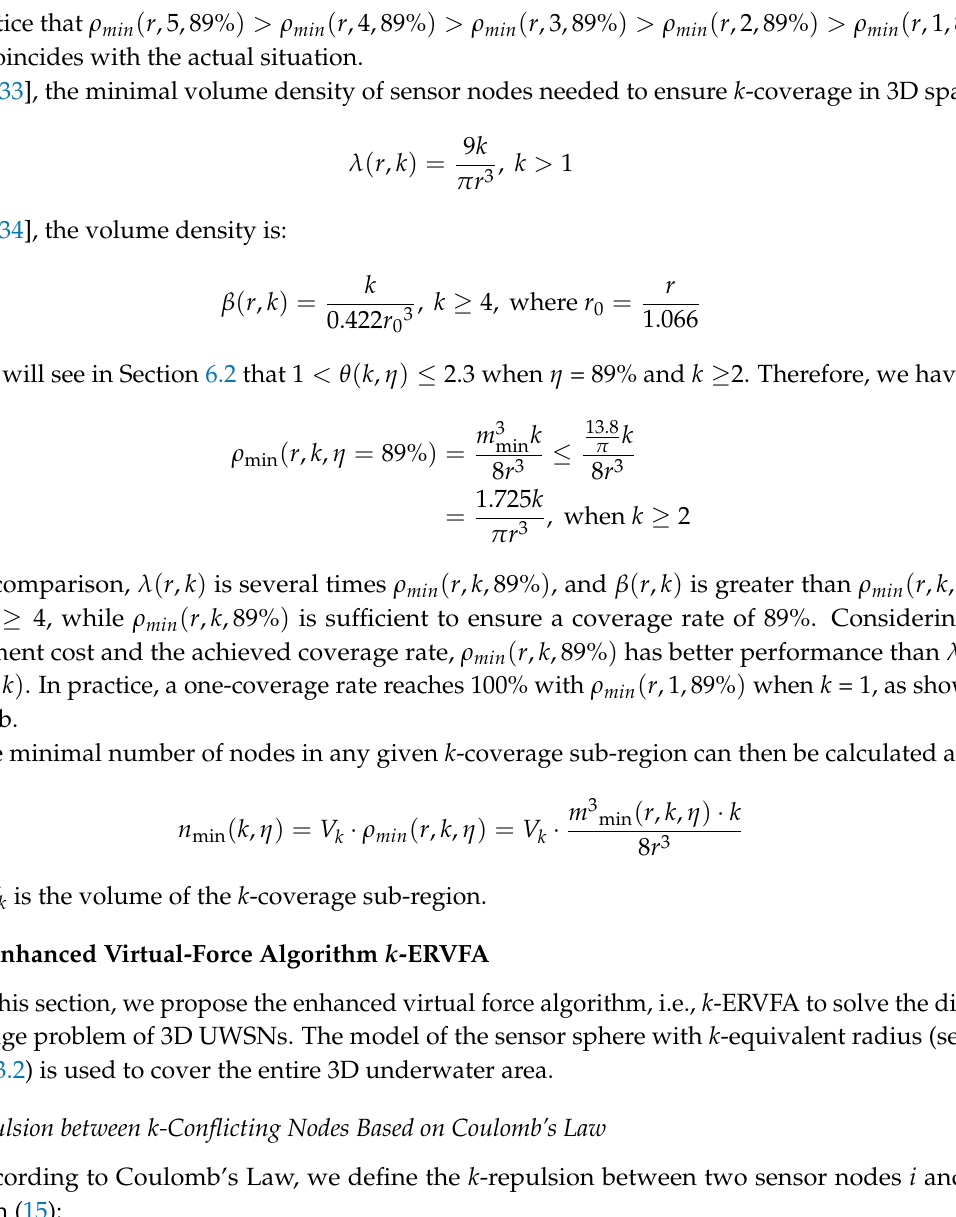
√ (cid:113) (cid:113) (cid:113) (cid:113) 12 12 12 13.8 3 3 3 3 3 ... π π π π √ 3 3 3 9 6 8.625 π r 3 π r 3 π r 8 r 3 2 π r 3